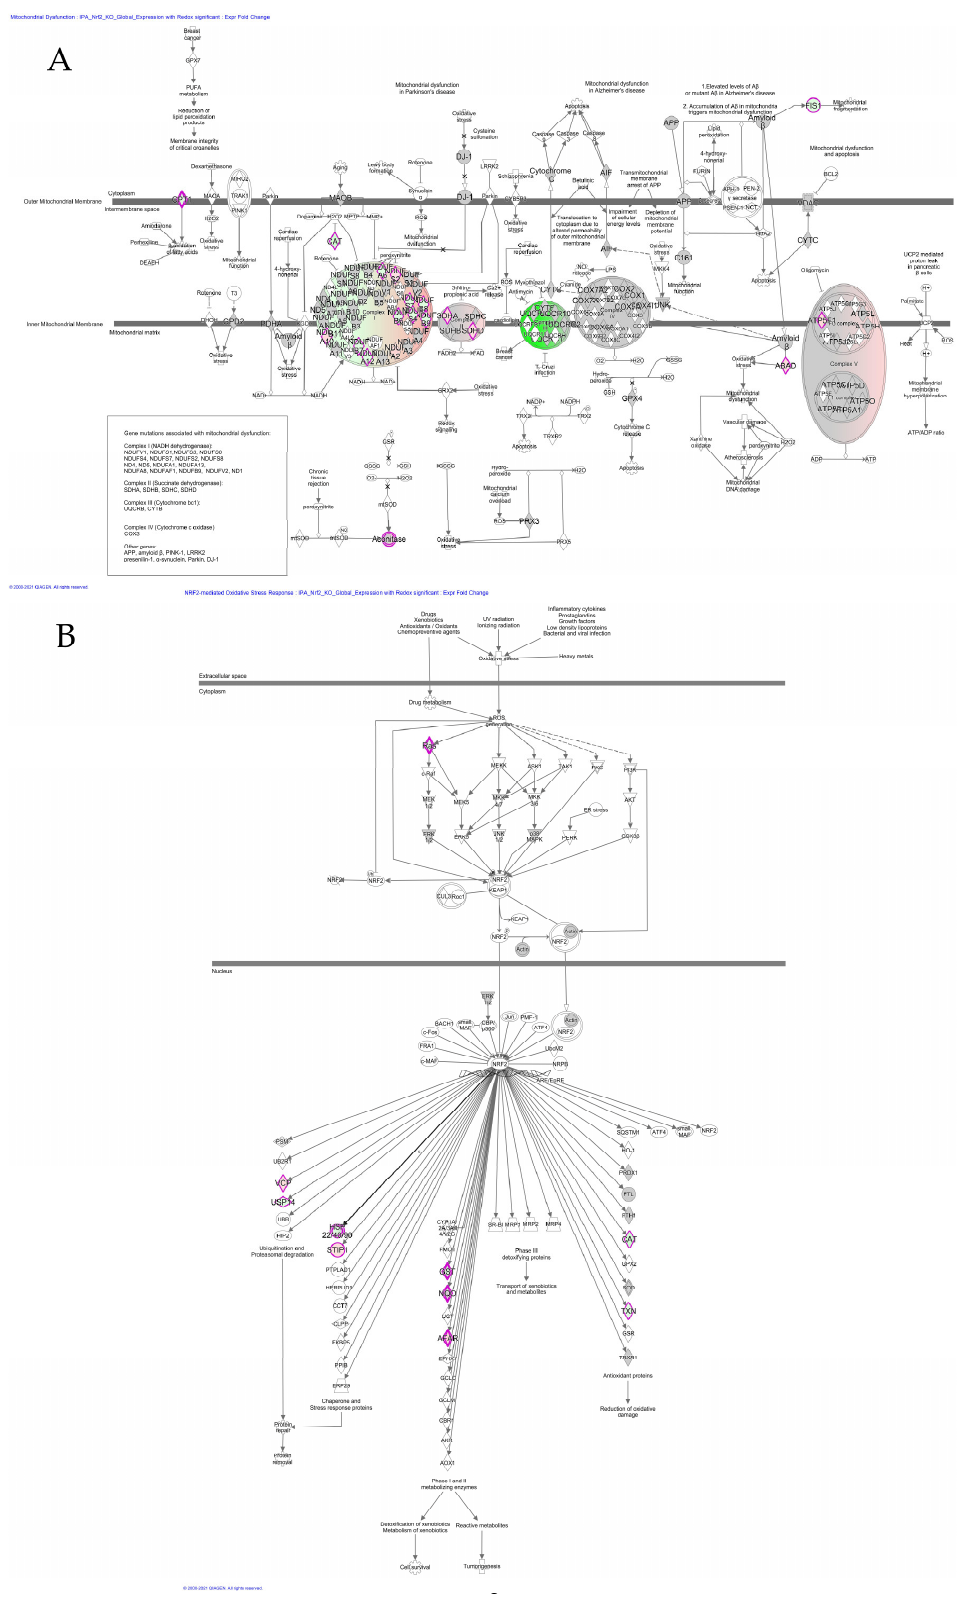
2 Figure 4. Nrf2-KO proteins significantly differentially expressed in energy metabolism and oxidative phosphorylation. ( A ) Mitochondrial dysfunction and oxidative phosphorylation pathway and ( B ) Nrf2-mediated oxidative stress response pathway. Upregulated/downregulated proteins are highlighted in magenta